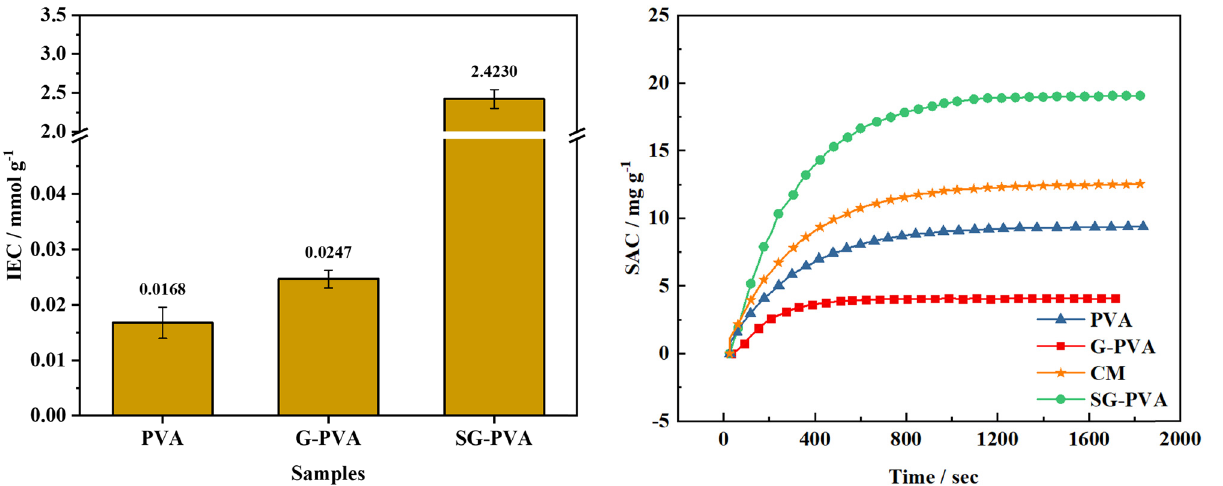
Figure 4: Cation exchange capacity of PVA, G - PVA, and SG - PVA.